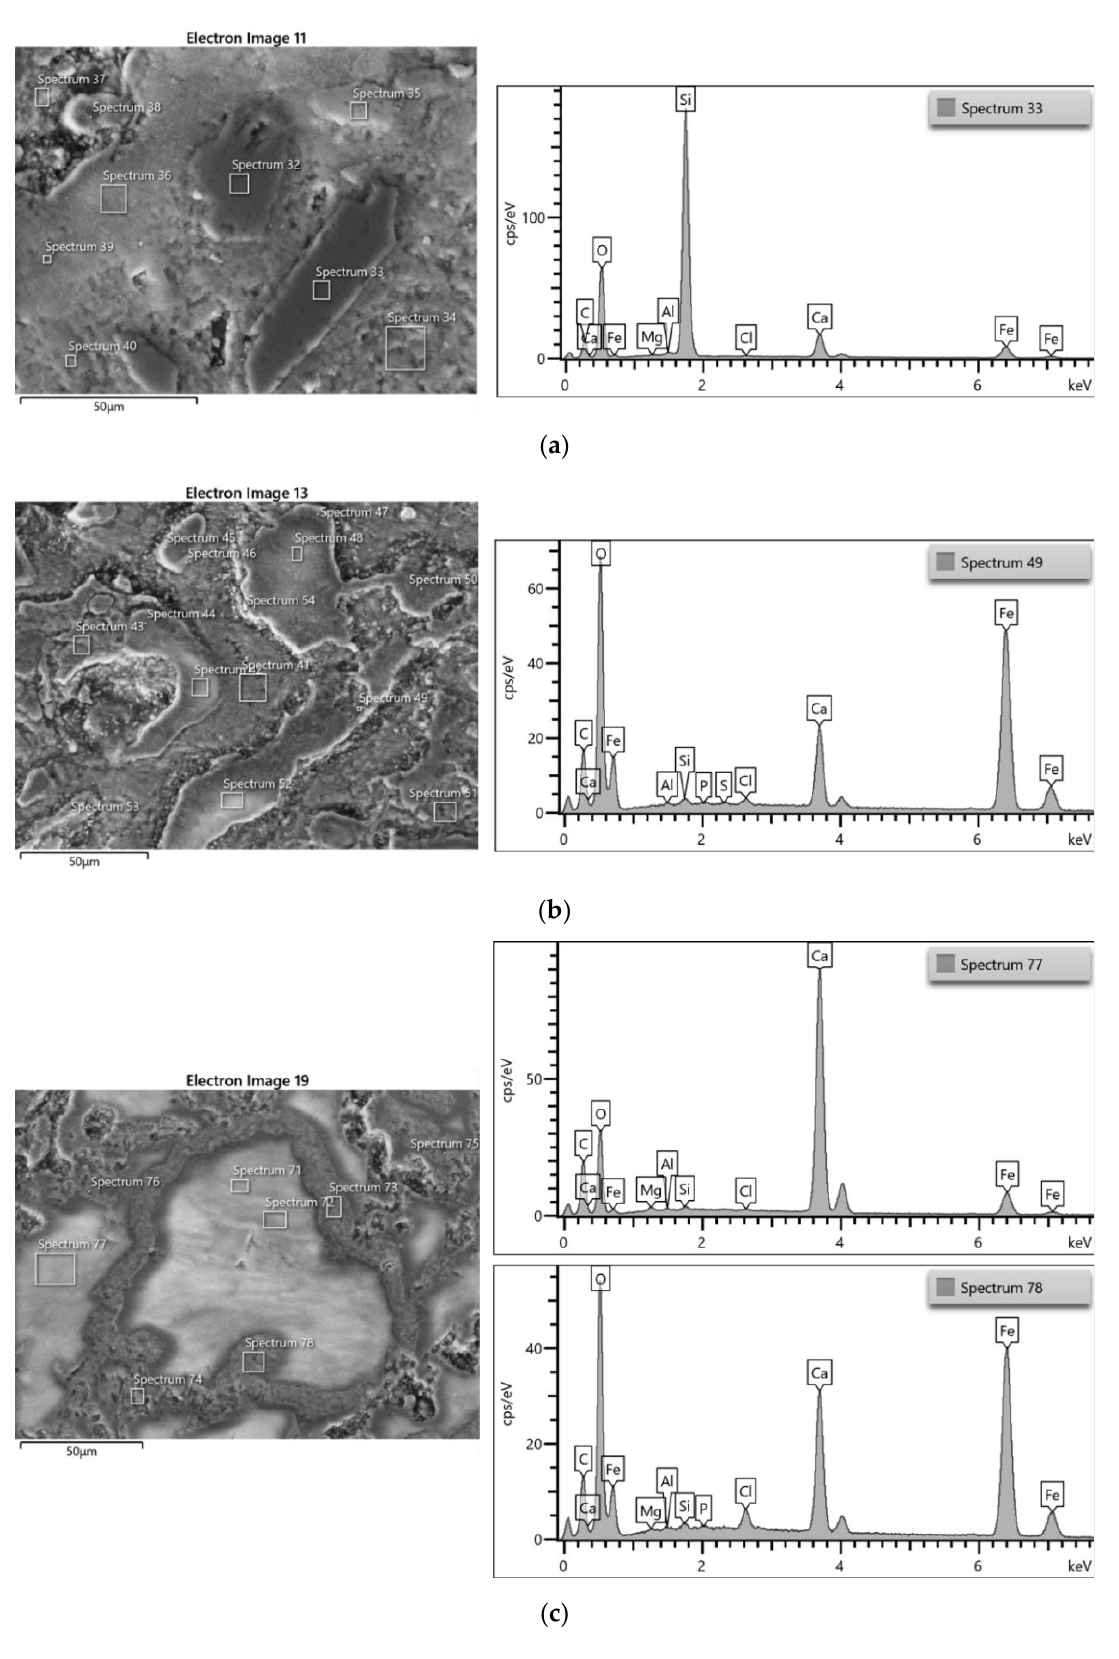
Figure 9. SEM images and EDS spectra of the sample 32: ( a – c ) detailed spectra for each area selected.